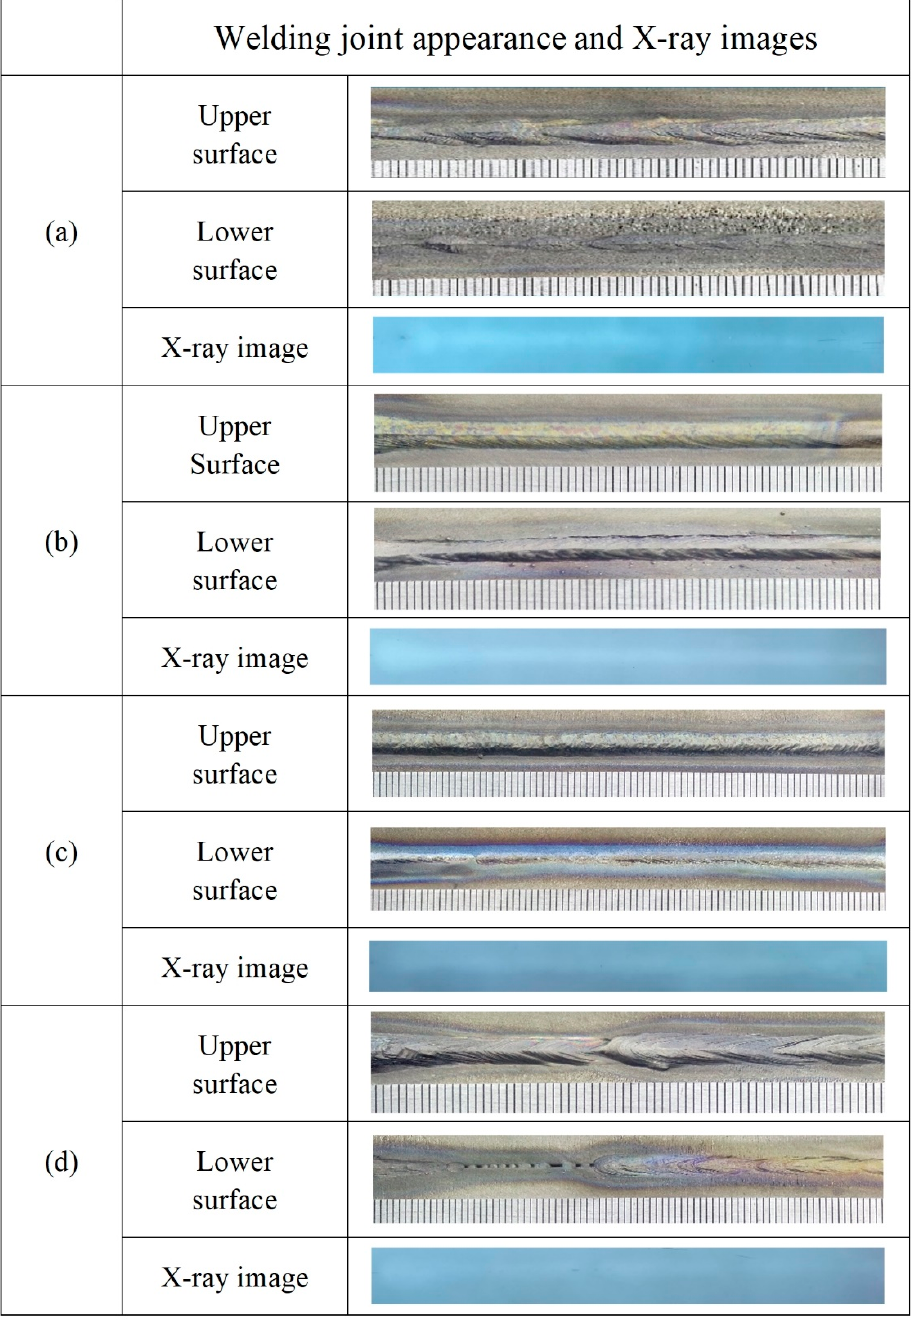
Figure 6. The welding surface appearance and X-ray images at the different BSGFR; ( a ) 15 L/min; ( b ) 25 L/min; ( c ) 35 L/min; ( d ) 45 L/min.